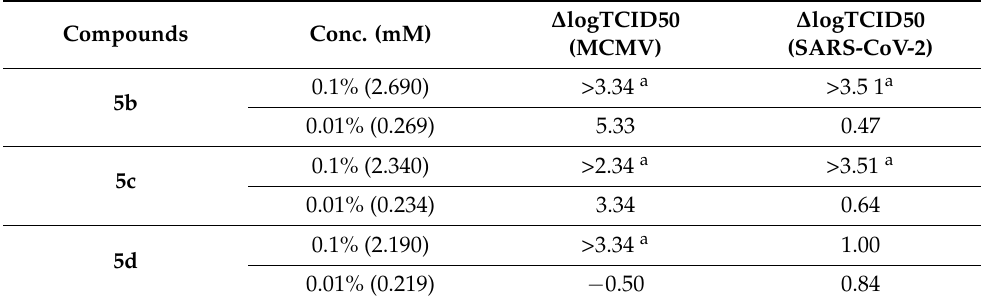
Table 4. Determination of virucidal activity against MCMV and SARS-CoV-2 (5 min exposure). Compounds